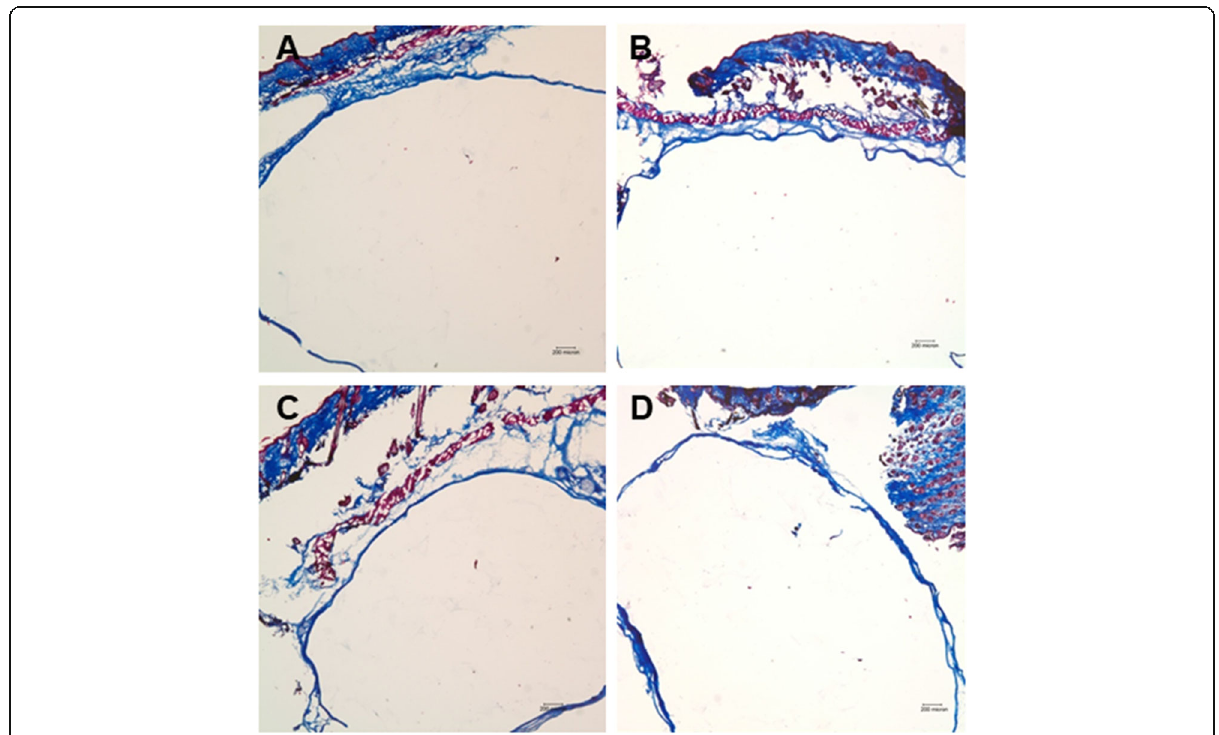
Fig. 5 Microscopic view of the hyaluronan gel filler (HGF) groups stained with Masson ’ s trichrome stain. There was no soft tissue staining inside the filler material (Masson ’ s trichrome; original magnification, × 40). a Hyaluronan gel filler alone, b hyaluronan gel filler combined with bFGF, c